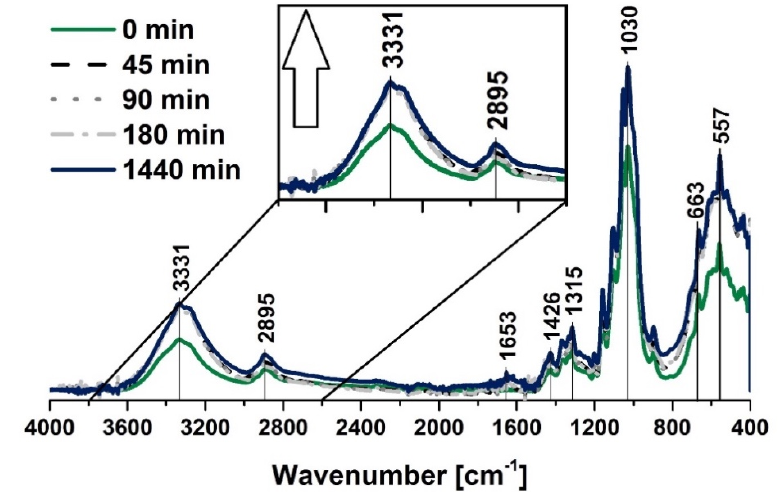
Figure 2. FT-IR spectra of the cellulose fibers that were dried for 1440 min at 100 °C and then left to adsorb moisture for different times. Characteristic absorption bands: 3334 cm − 1 (O–H, water), 2894 cm − 1 (C–H), 1200–900 cm − 1 (O–H, C–O, –COO, CO–O–CO), and 558 cm − 1 (C–OH, C–C).